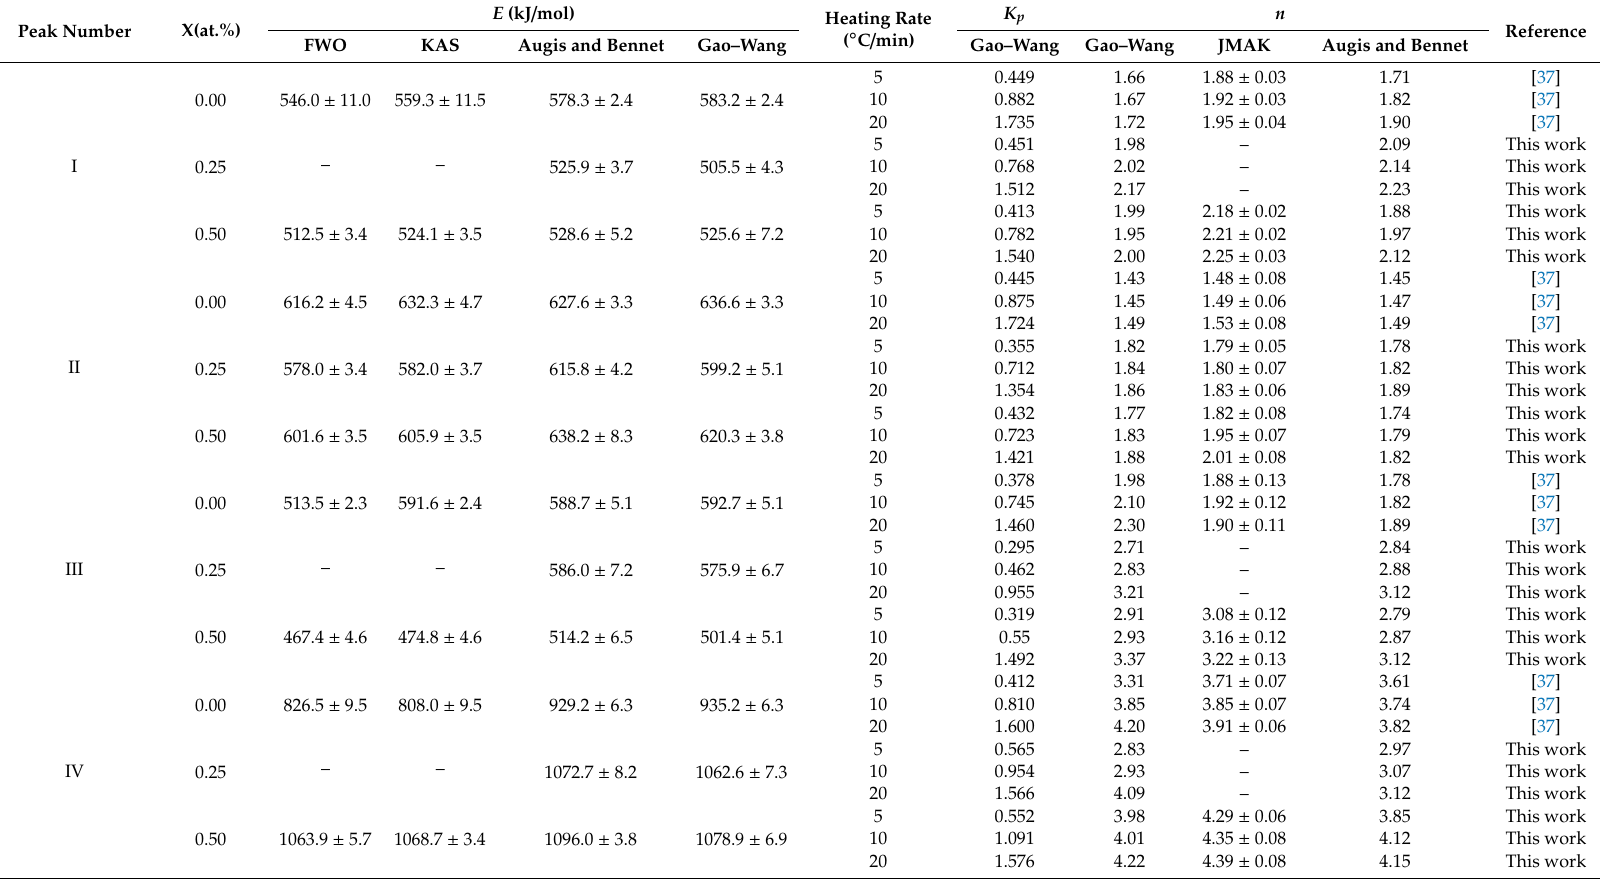
Table 2. Values of kinetic parameters including; activation energy ( E ), Avrami exponent ( n ) and the value of constant rate of maximum peak ( K p ) by using di ff erent methods for all crystallization